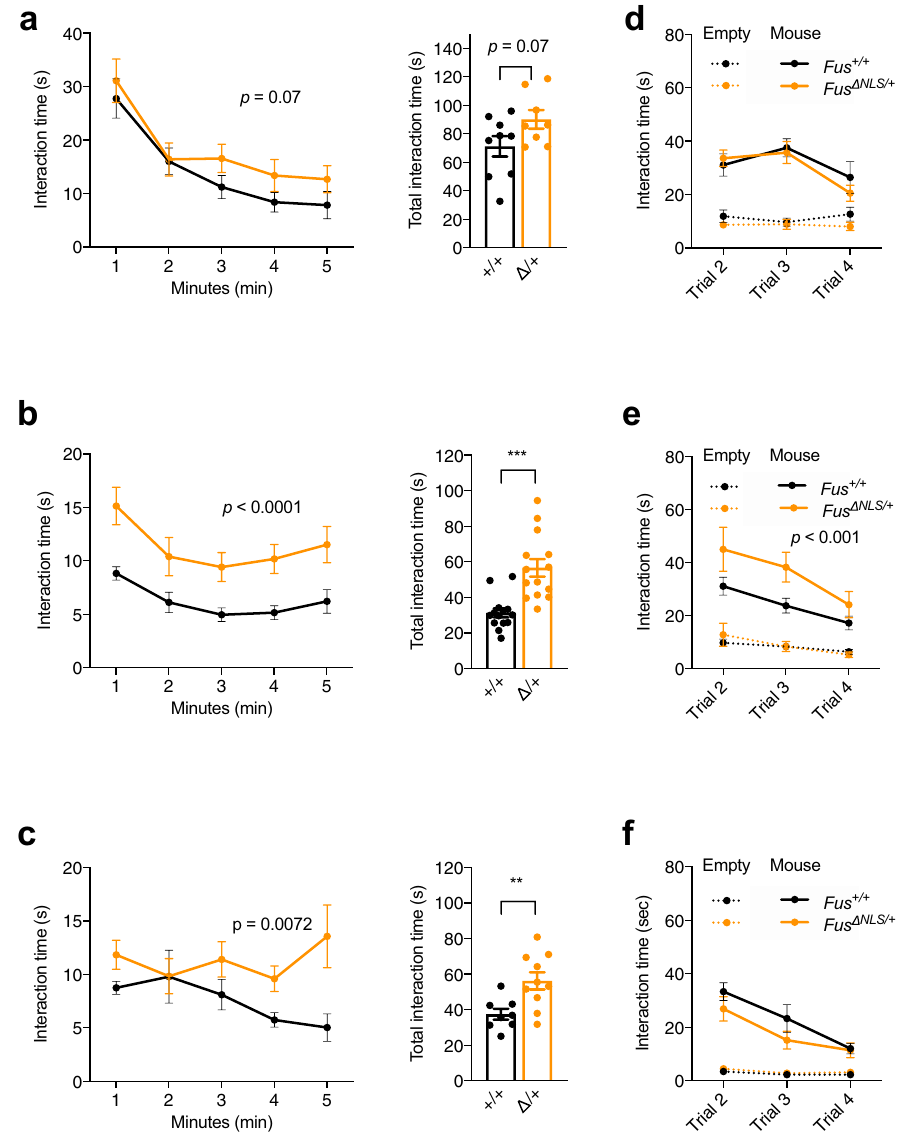
Fig. 2 Social behavior abnormalities in Fus Δ NLS/ + mice. a – c Line and bar graphs represent interaction time between resident (test) and intruder mice exclusively initiated by resident mouse in one-minute intervals (line graphs, on the left) or over the total time (bar graphs, on the right) during a 5 min resident-intruder test in home cage for 4 ( a ), 10 ( b ), and 22 ( c ) months-old Fus + / + (black) and Fus Δ NLS/ + (orange) male mice. Note that, young Fus Δ NLS/ + mice demonstrated a trend towards an increased social interest for intruder mouse ( a ) while older mice interacted with intruders signi fi cantly longer then Fus + / + ( b , c ) showing an age-dependent impairment of social behavior – disinhibition. All values are represented as mean ± SEM. At 4 months, N = 9 for Fus + / + and N = 8 for Fus Δ NLS/ + mice; At 10 months, N = 14 for Fus + / + and N = 14 for Fus Δ NLS/ + mice; At 22 months, N = 8 for Fus + / + and N = 10 for Fus Δ NLS/ + mice. Two-way repeated measures ANOVA followed by Sidak post-hoc test ( p = 0.07 (4 months), p < 0.001 (10 months), and p = 0.007 (22 months) for genotype.effect); Two-sided Unpaired Student ’ s t -test for total time p = 0.07 (4 months), p < 0.001 (10 months), and p = 0.007 (22 months)). d , f Line graphs represent sociability in the three-chamber test measured as interaction time with novel mice across three trials for Fus + / + (black) and Fus Δ NLS / + (orange) male mice at 4 ( d ), 10 ( e ), and 22 ( f ) months of age. Time exploring an empty cage (object) across trials is represented as dashed lines. At 4 months, N = 9 for Fus + / + and N = 8 for Fus Δ NLS/ + mice; At 10 months, N = 14 for Fus + / + and N = 14 for Fus Δ NLS/ + mice; At 22 months, N = 8 for Fus + / + and N = 9 for Fus Δ NLS/ + mice. Data are presented as mean ± SEM. Three-way ANOVA with Newman Keuls post-hoc test for multiple comparisons, p = ns (4 months), p < 0.001 (10 months) and p = ns (22 months) for genotype effect). Source data are provided as a Source Data fi